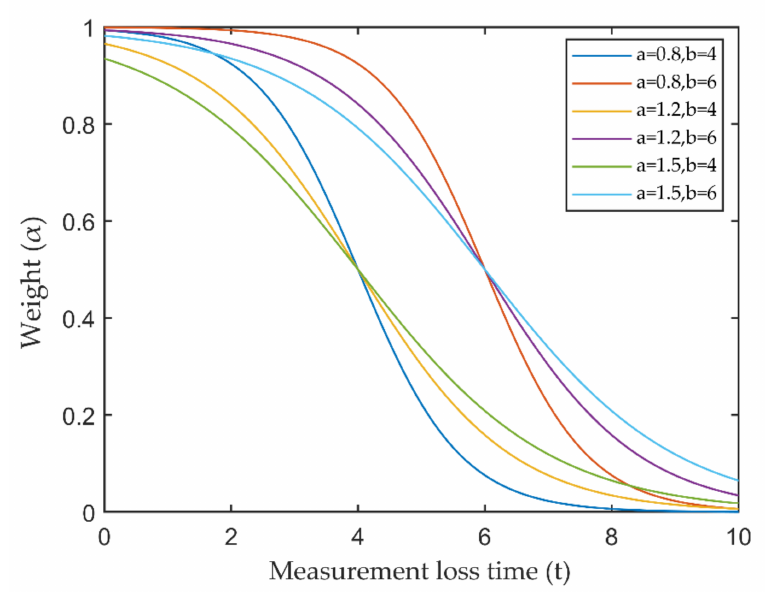
Figure 4. Visualization of weight attenuation